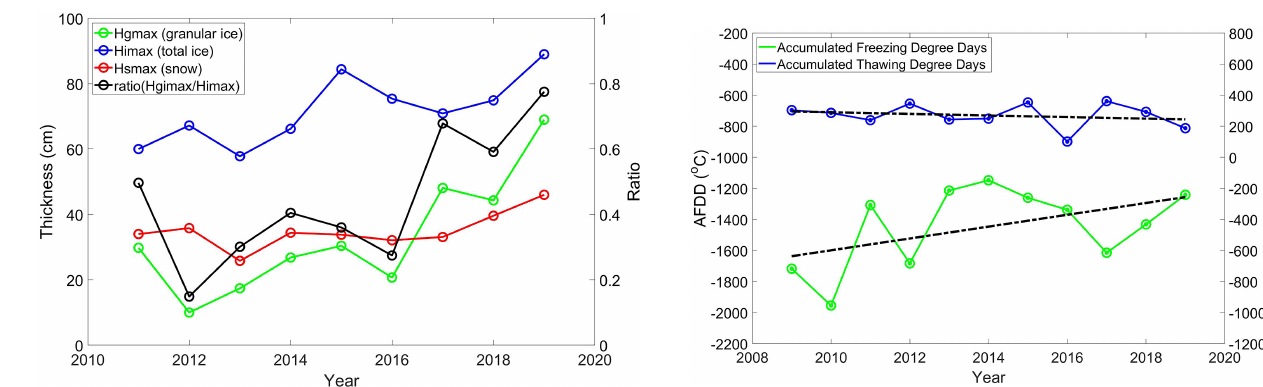
Figure 9. SIMBA observed seasonal maximum snow depth (red), maximum total ice thickness (blue), maximum granular ice thick- ness (green), and the ratio between granular ice and total ice thick- ness (black) during observation seasons.